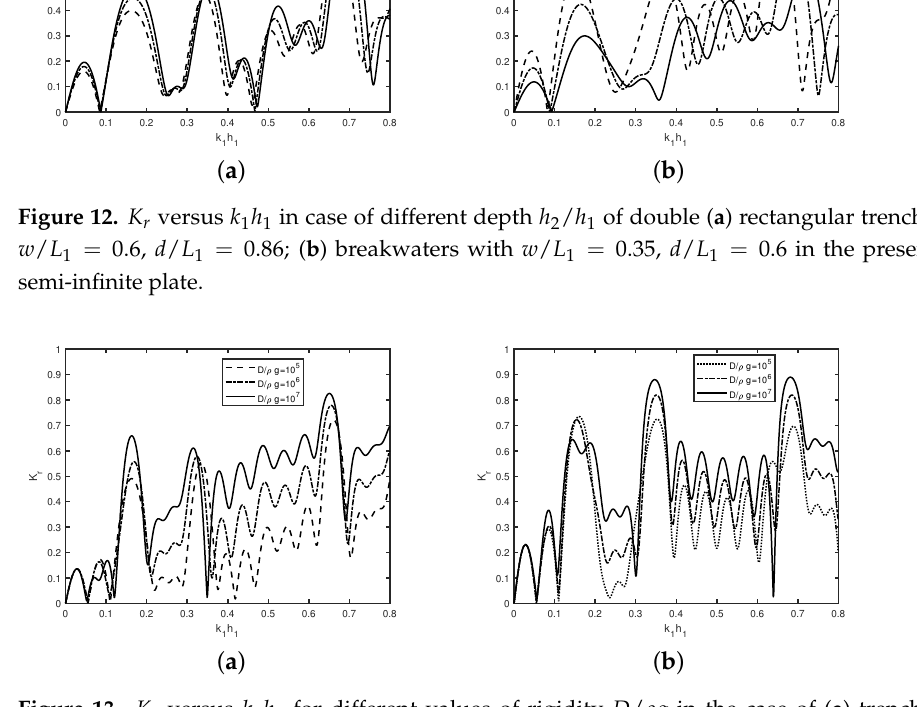
Figure 13. K r versus k 1 h 1 for different values of rigidity D / ρ g in the case of ( a ) trenches with w / L 1 = 0.6, d / L 1 = 0.86; ( b ) breakwaters with w / L 1 = 0.35, d / L 1 = 0.6 in the presence of a semi-infinite plate with L g / L 1 = 0.25 and N =